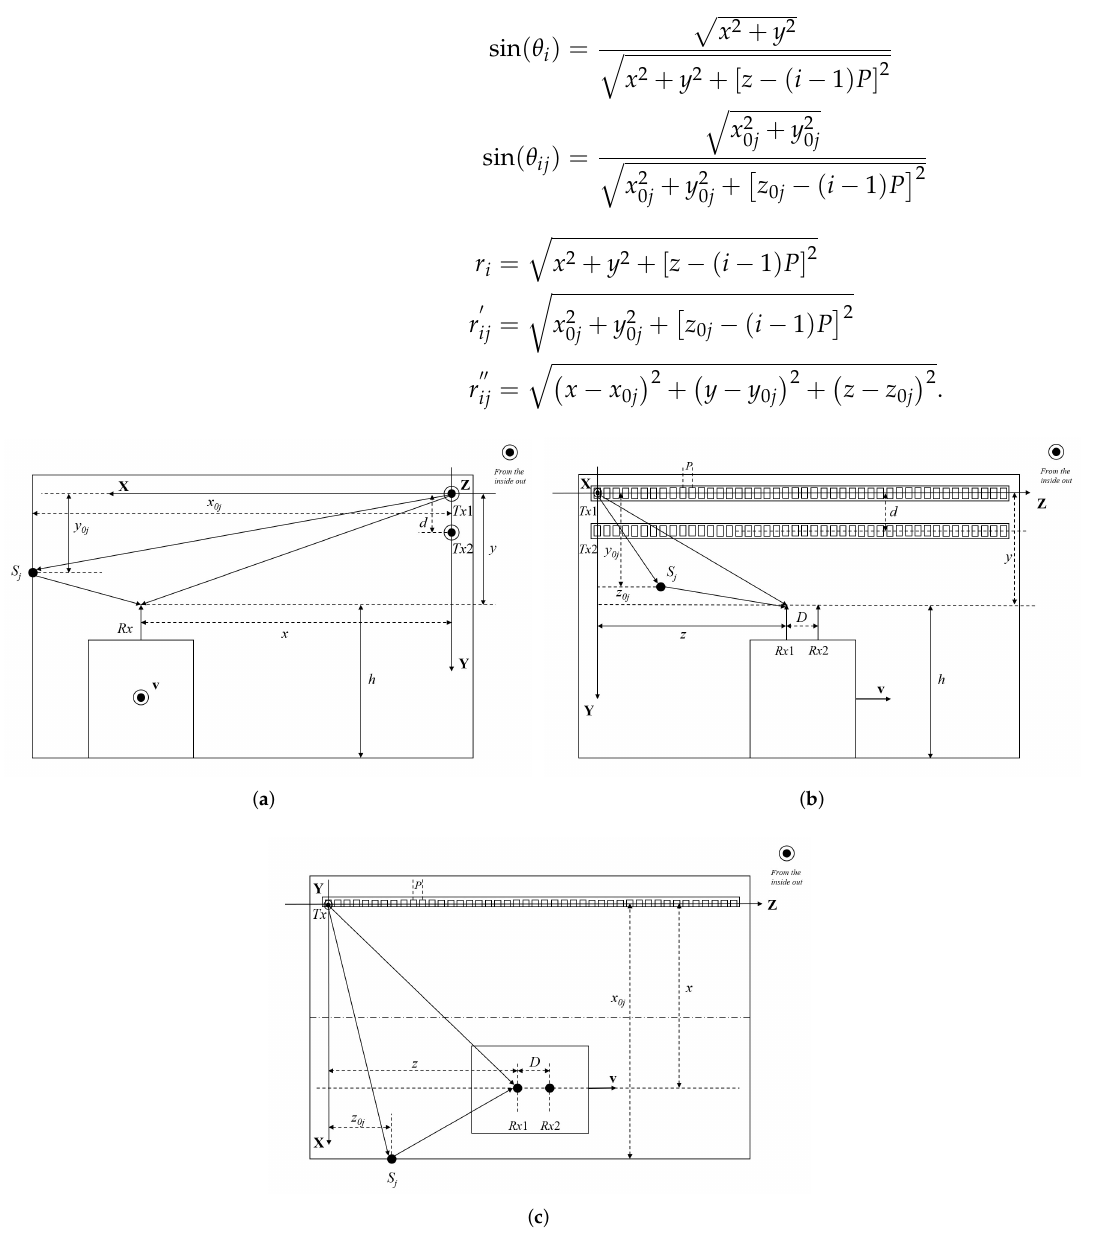
Figure 3. The projection view of the signal propagation in the tunnel (LCXs on the far side): ( a ) front view; ( b ) side view; ( c ) top